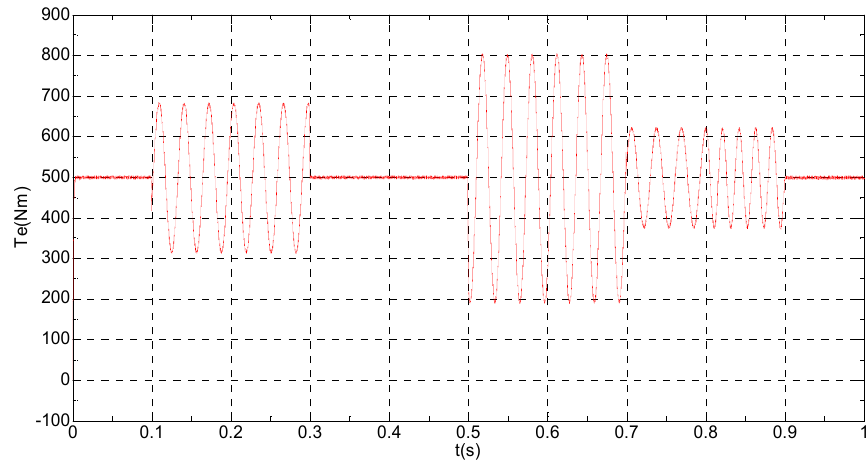
Figure 8. The electromagnetic torque.